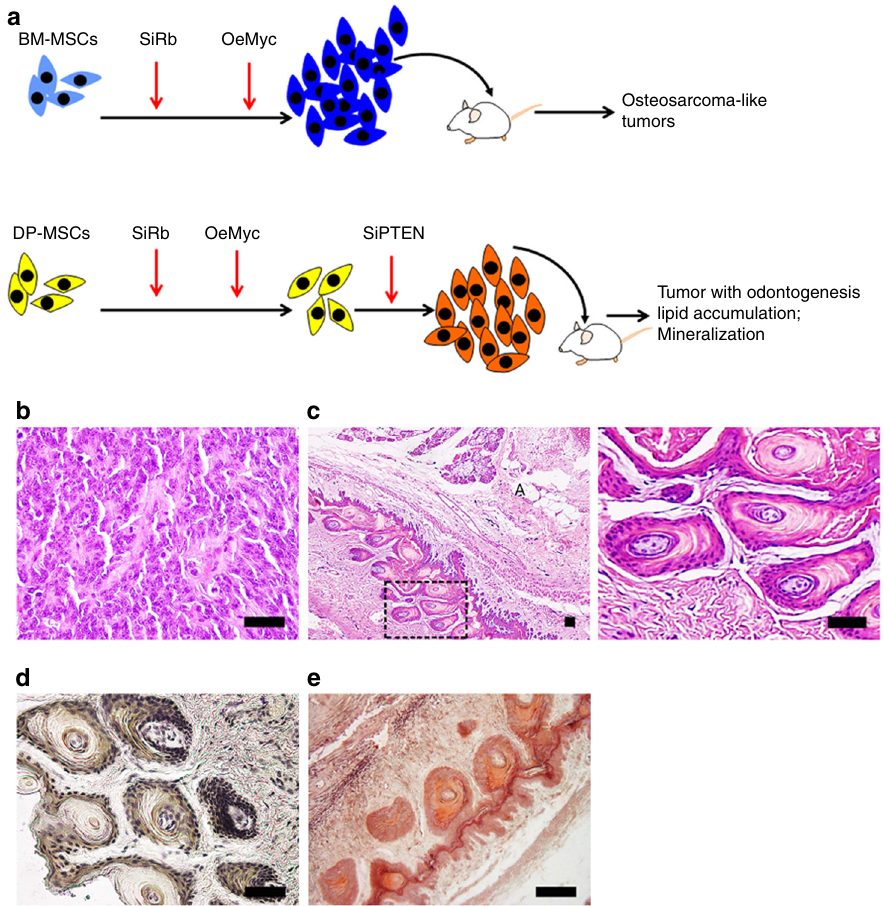
Fig. 7 PTEN silencing increases tumorigenesis. a Flow chart showing the protocols for oncogenic transformation of BM-MSCs and DP-MSCs. Transformed BM-MSCs (SiRb-OeMyc) formed osteosarcoma-like tumors in immunode fi cient mice ( b ), while transformed DPSCs (SiRb-OeMyc-SiPTEN) formed odontogenic tumors associated with osteoid and adipose tissues ( c – e ). Sections of transplants were analyzed by H&E ( b , c ), immunohistochemistry of DSP ( d ), and Alizarin Red S ( e ). A in ( c ): adipose tissue. c , right The rectangular area is shown at higher magni fi cation. Bar = 50 μ m. SiRb: knockdown of